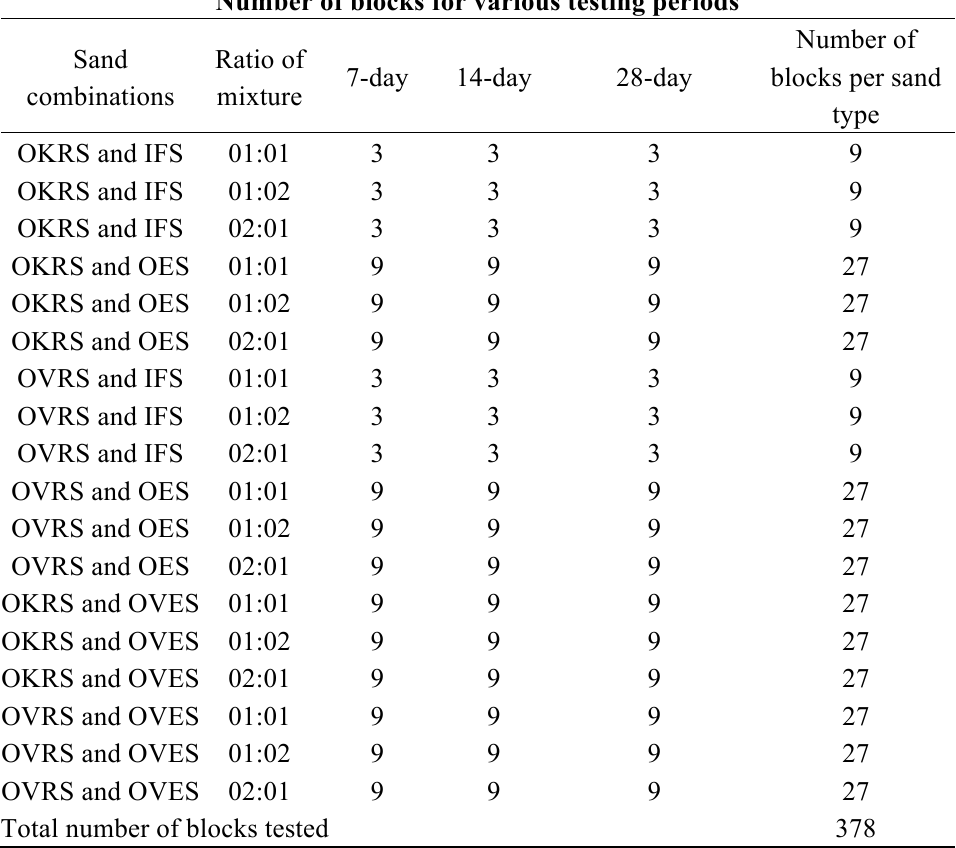
Table 2. Number of 225 mm blocks from sand combinations for various testing periods and vibration times.